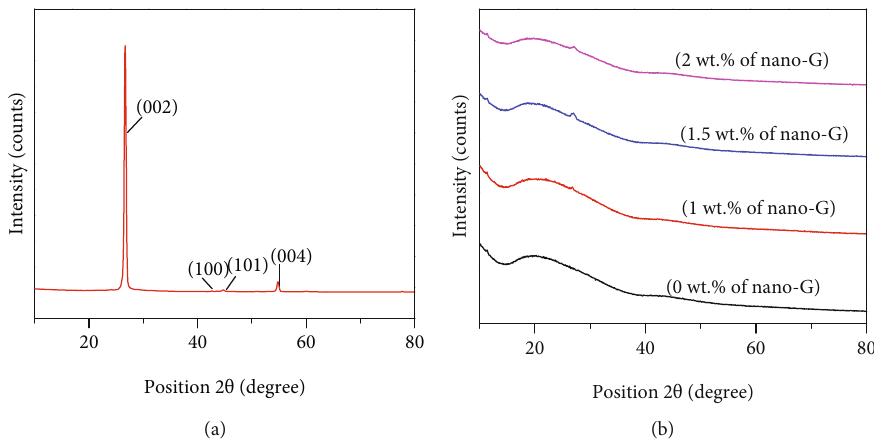
Figure 1: XRD pattern of nanographite (b). XRD pattern of